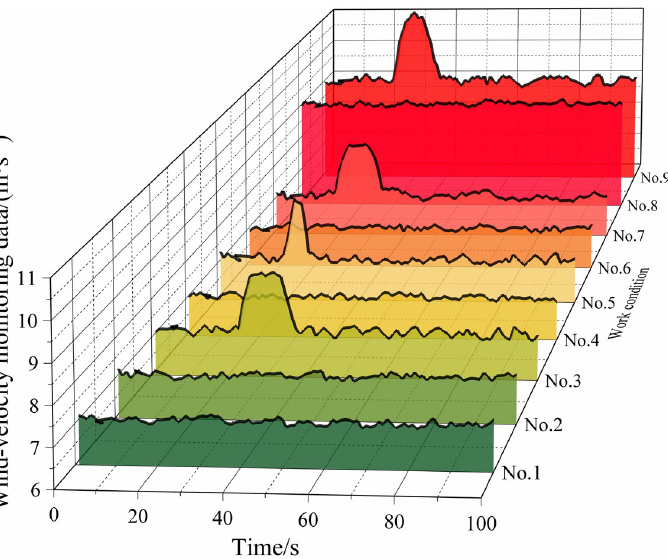
Fig 11. Wind-velocity data recorded at monitoring Point